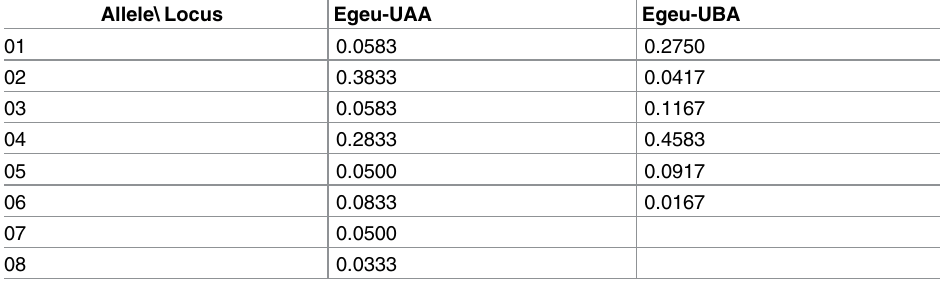
Table 1. Allele frequency of MHC class I genes in the Chinese